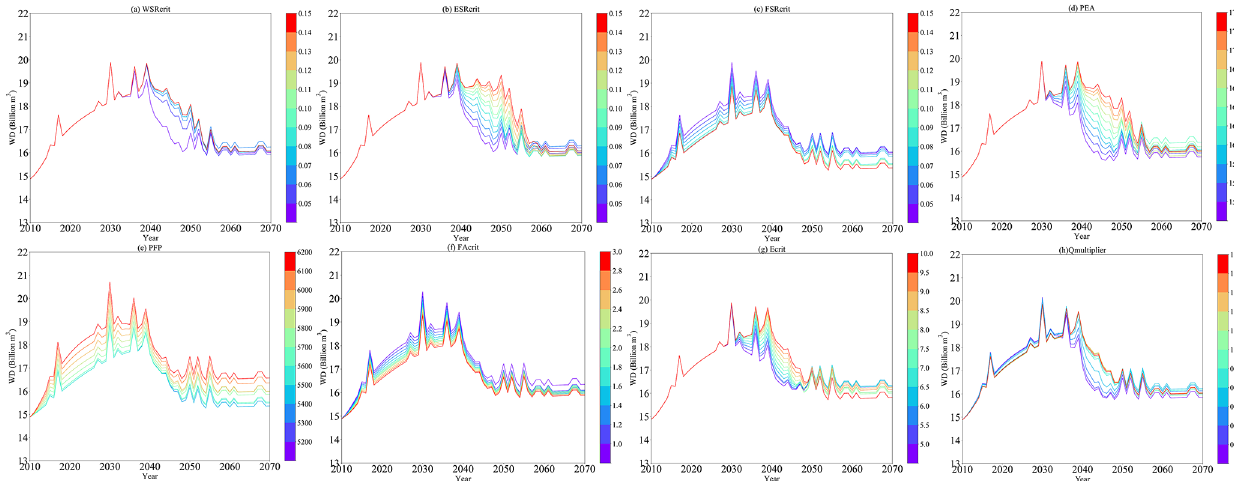
Figure 9. Trajectories of water demand with varied